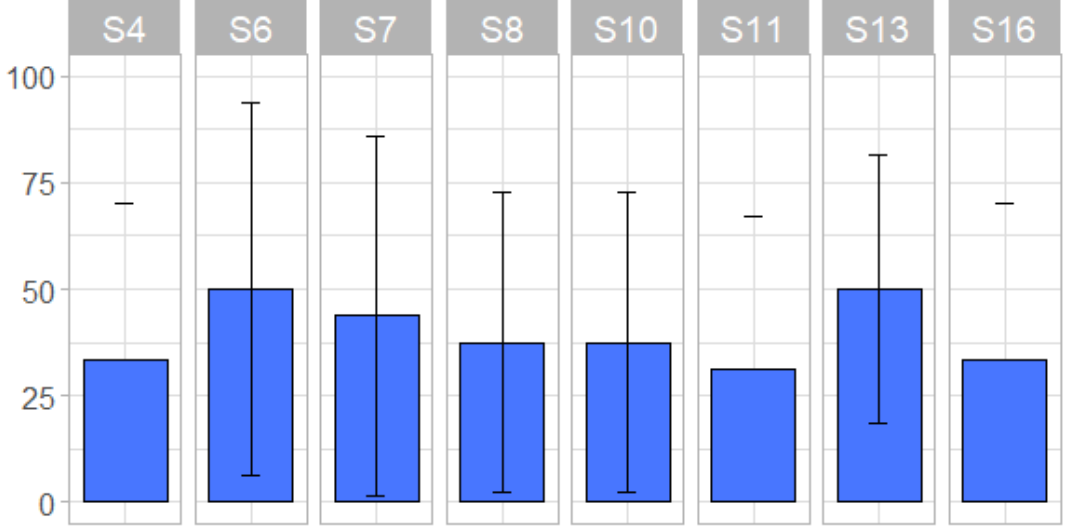
Table 1. Results of the binomial mixed-effects model (Intercept: groupIQ high, contrast /æ/–/ ɑː /).